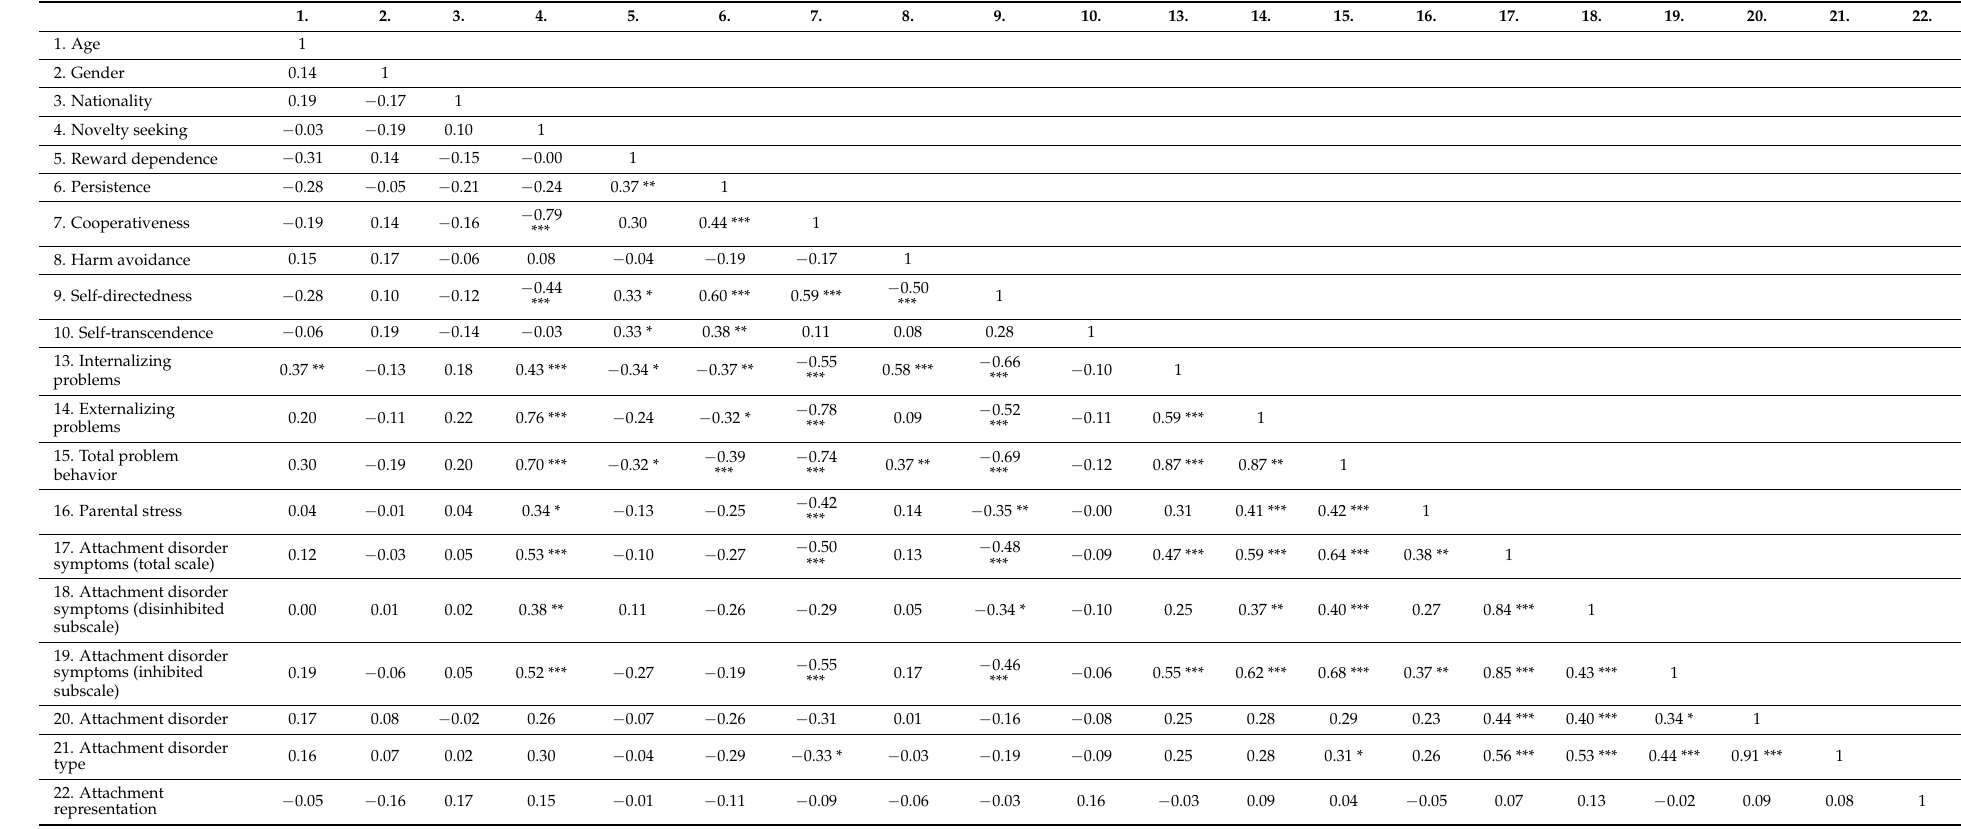
Table 2. Correlation matrix of all study